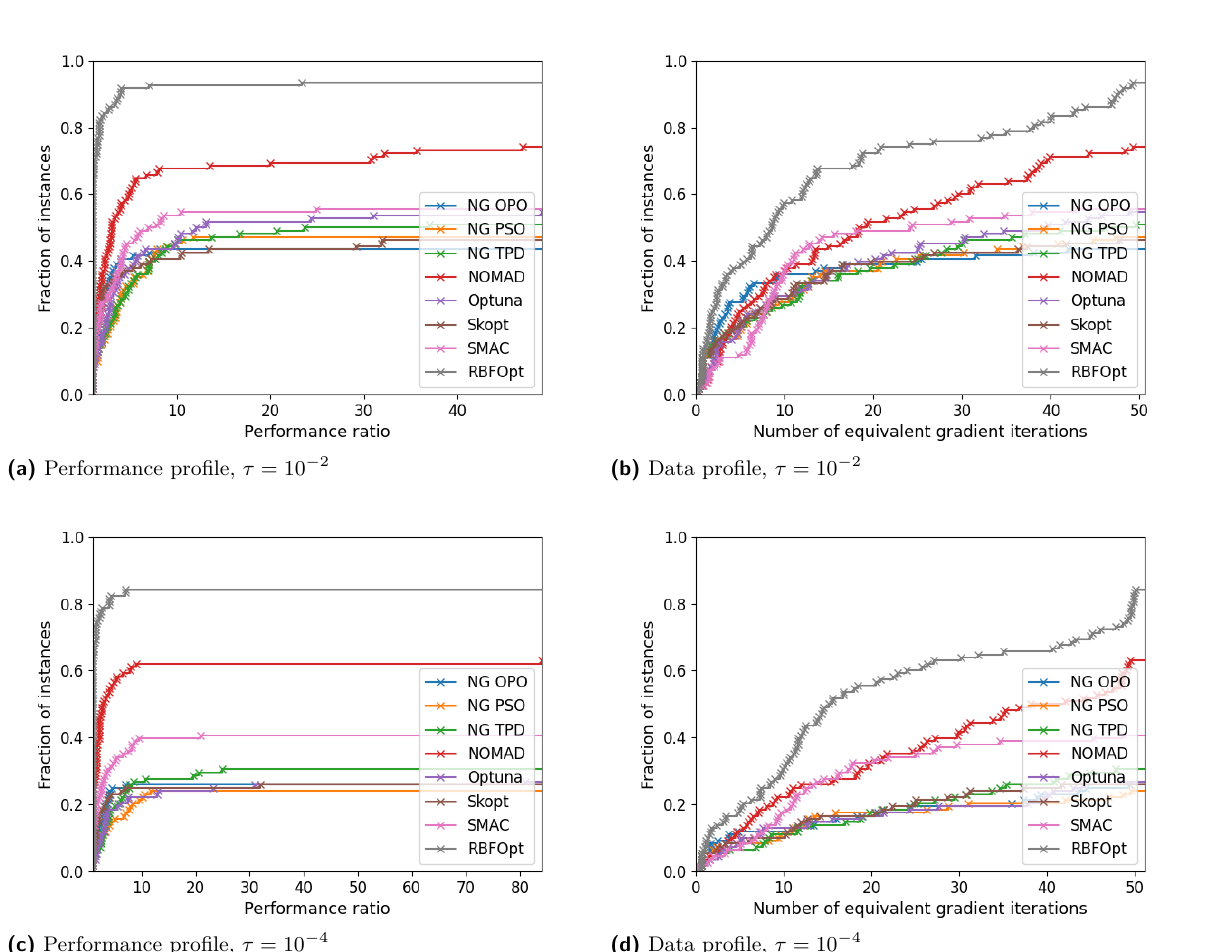
Figure 6 Performance profiles (left) and data profiles (right) comparing: Nevergrad OnePlusOne, Nevergrad Particle Swarm Optimization, Nevergrad TwoPointsDE, NOMAD, Optuna, Scikit-Optimize, SMAC, and